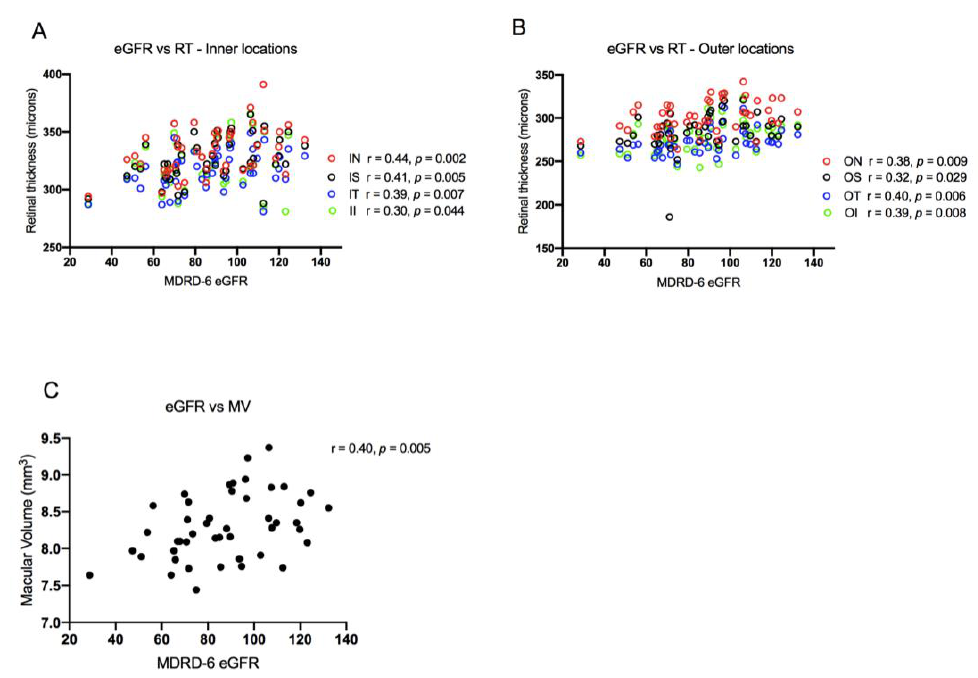
Figure 3. ( A , B ) Scatter plots of retinal thickness (RT) with estimated glomerular filtration rate (eGFR). ( C ) Scatter plot of macular volume (MV) and estimated glomerular filtration rate. Pearson correlation coefficients are shown (top right). IN, inner nasal; IS, inner superior; IT, inner temporal; II, inner inferior; ON, outer nasal; OS, outer superior; OT, outer temporal; OI, outer inferior. MDRD-6, Modification of Diet in Renal Disease-6 equation.